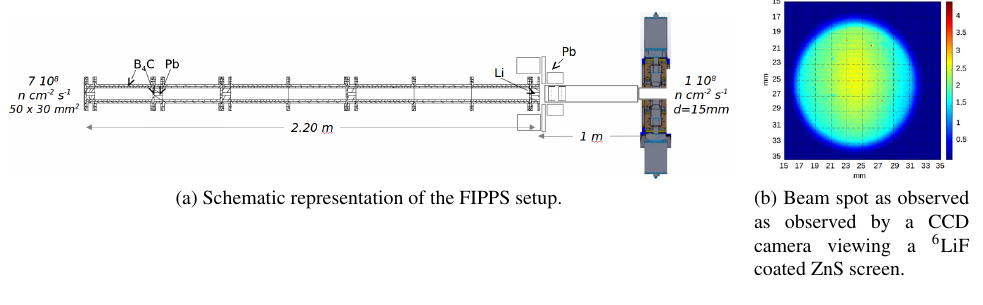
Figure 1: FIPPS setup and collimated neutron